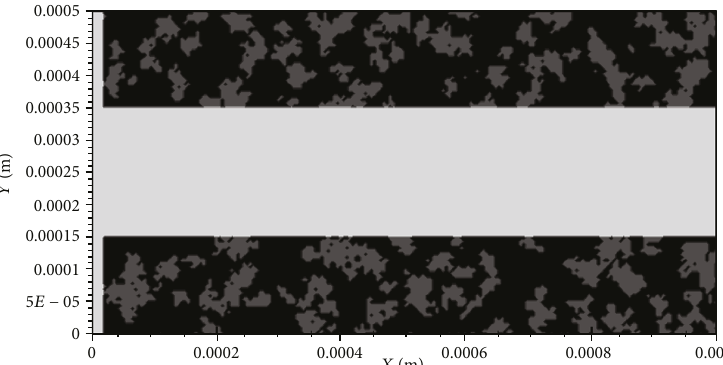
Figure 2: The geometry of a single fracture (in light gray) surrounded by reactive (in black) and nonreactive (in dark gray) minerals. In multispecies simulations, dark gray is kaolinite and black is calcite. The QSGS algorithm was used to grow nonreactive minerals inside a reactive mineral (in black) to form a mixed structure.